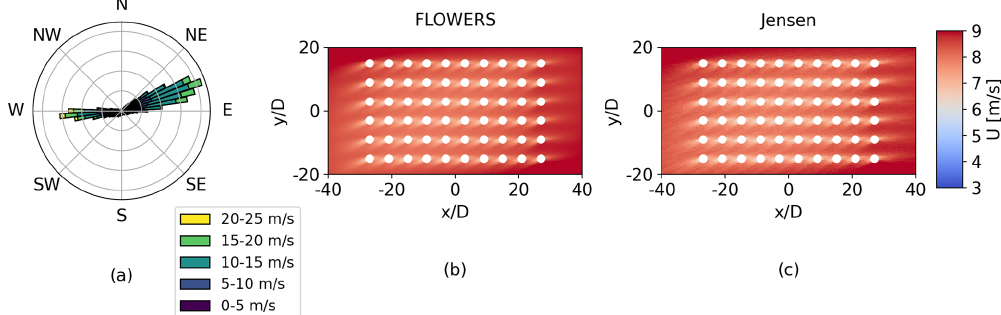
Figure 4. Flow field comparison for a 60-turbine wind farm with 6 D spacing with a realistic wind rose (corresponding to an offshore site in the northwest US) (a) . Again, the number of wind direction bins B in the numerical method (c) is B = 72 , and the number of Fourier coefficients in FLOWERS (b) is N =